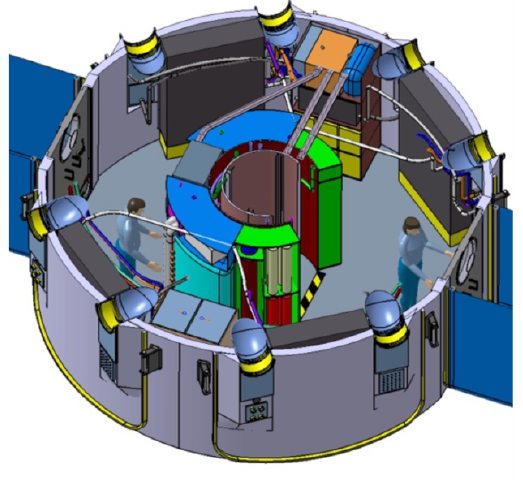
Figure 4: The middle level of the inner rigid core of the GHM system. Figure 5: The lower level of the inner rigid core of the GHM system.